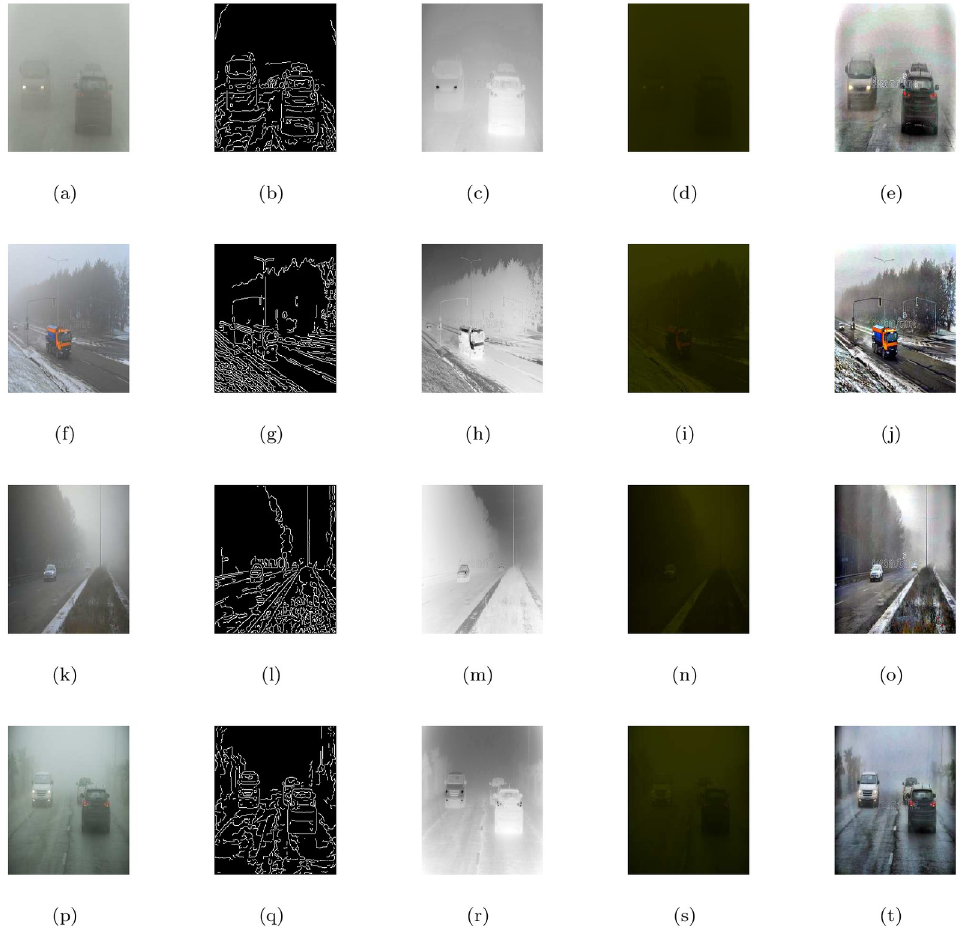
Fig 3. De-hazing results of the proposed model (M3). From L to R, the original images (a,f,k,p), the corresponding visible edge maps (b,g,l,q), transmission maps (c,h,m,r), air-light maps (d,i,n,s) and final de-hazing results (e,j,o,t).